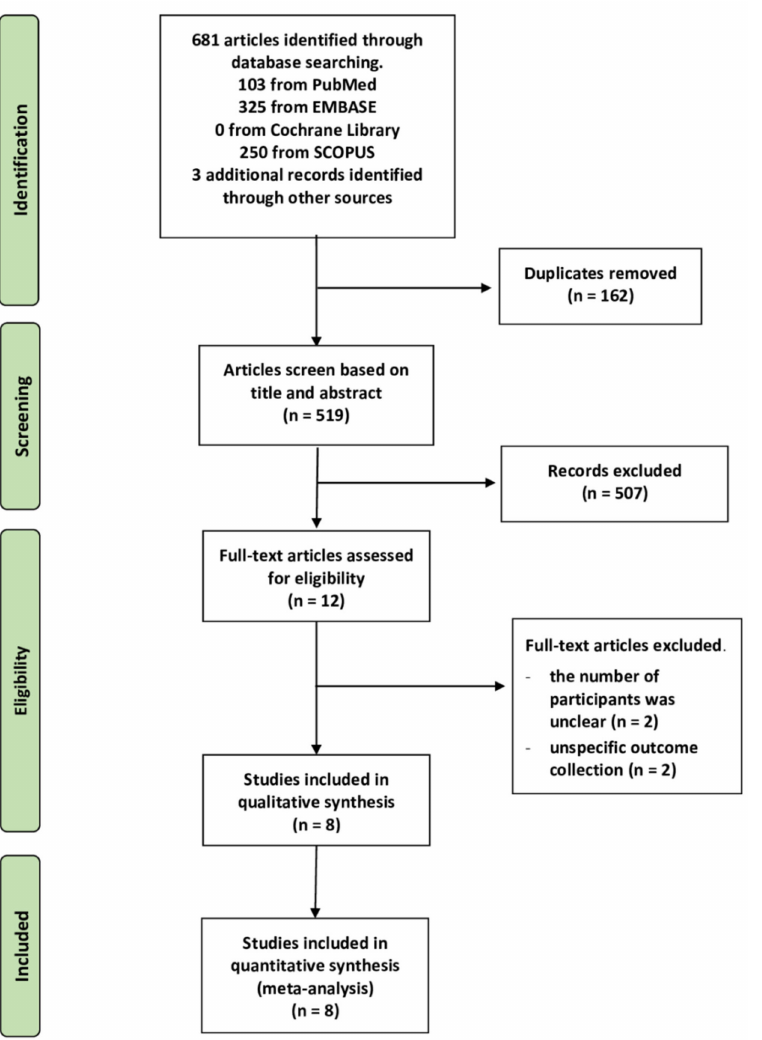
Figure 1. PRISMA flow diagram summary of the study selection